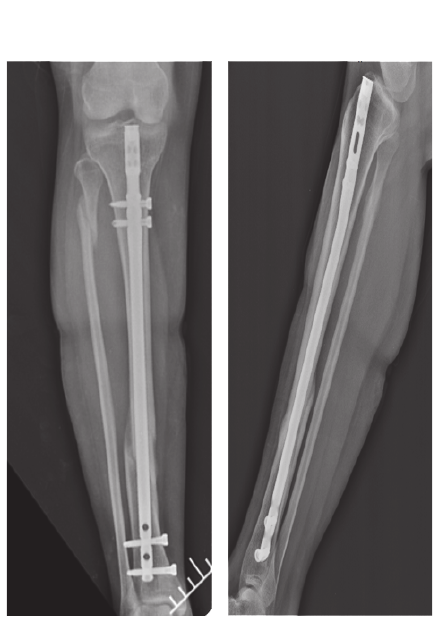
Figure 3: Radiographs showing united tibia at four